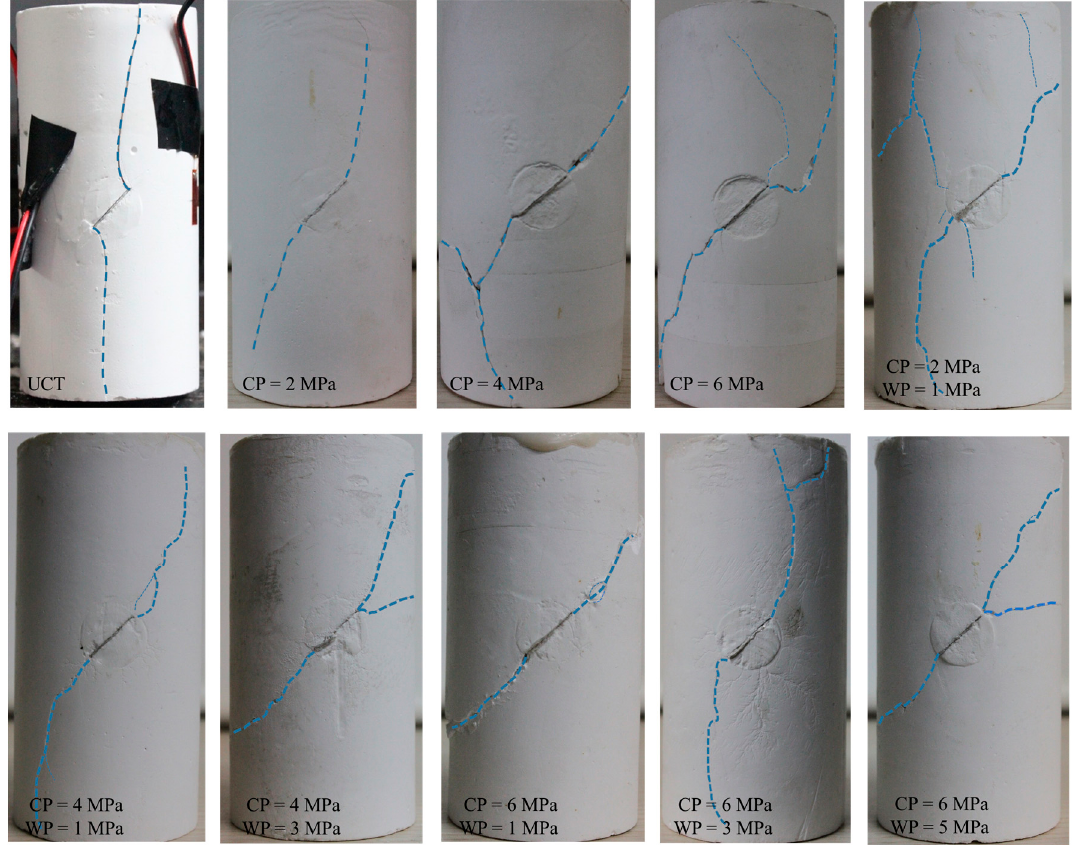
◦ specimens after